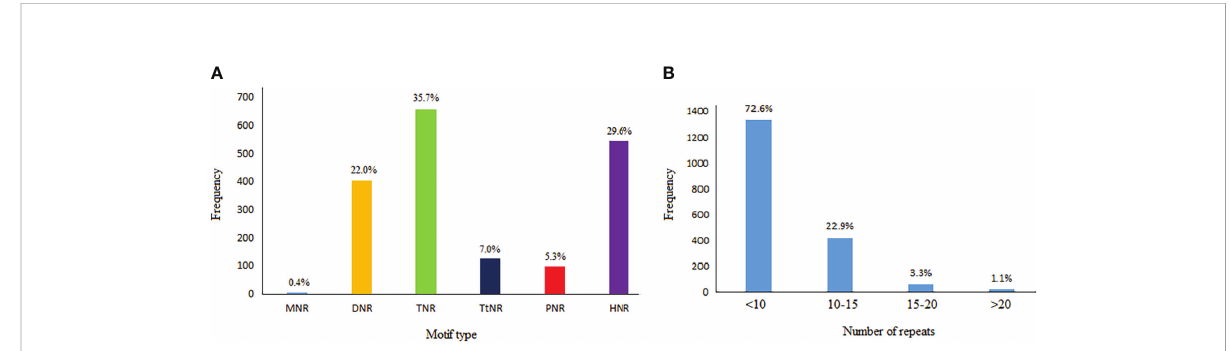
FIGURE 1 (A) Frequency distribution of 6 SSR motif types (viz. mono- to hexanucleotide repeats) in cDNA sequences of saf fl ower. (B) The number of repeats vs. frequency of different motifs in identi fi ed SSR sequences. MNR, mononucleotide repeat; DNR, dinucleotide repeat; TNR, trinucleotide repeat; TtNR, tetranucleotide repeat; PNR, pentanucleotide repeat; HNR, hexanucleotide